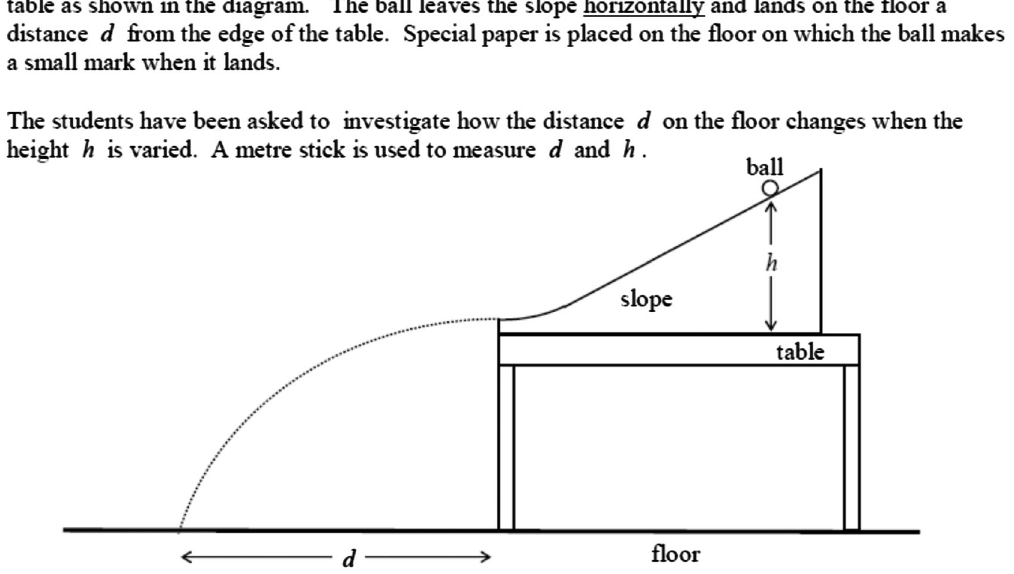
FIG. 8. Contextual information for the PMQ. This information precedes the probes themselves. Reproduced from Ref.